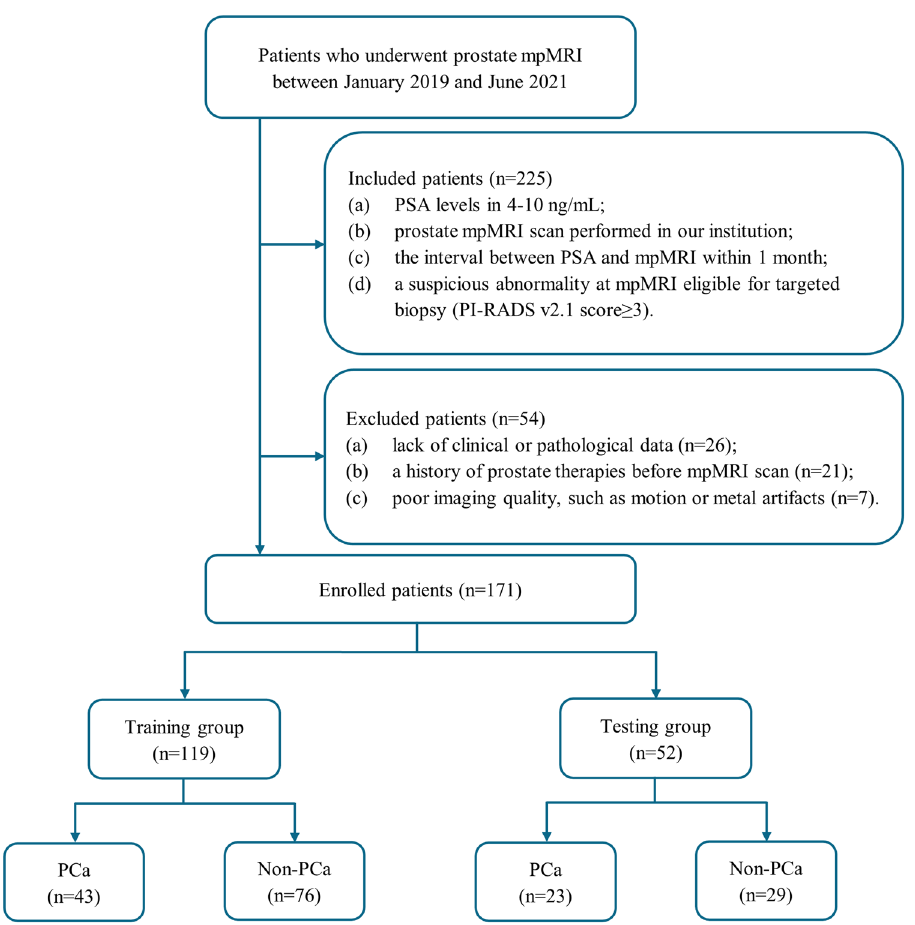
Figure 5. The study flowchart. mpMRI multiparametric magnetic resonance imaging, PSA prostate-specific antigen, PCa prostate cancer, Non-PCa non-prostate